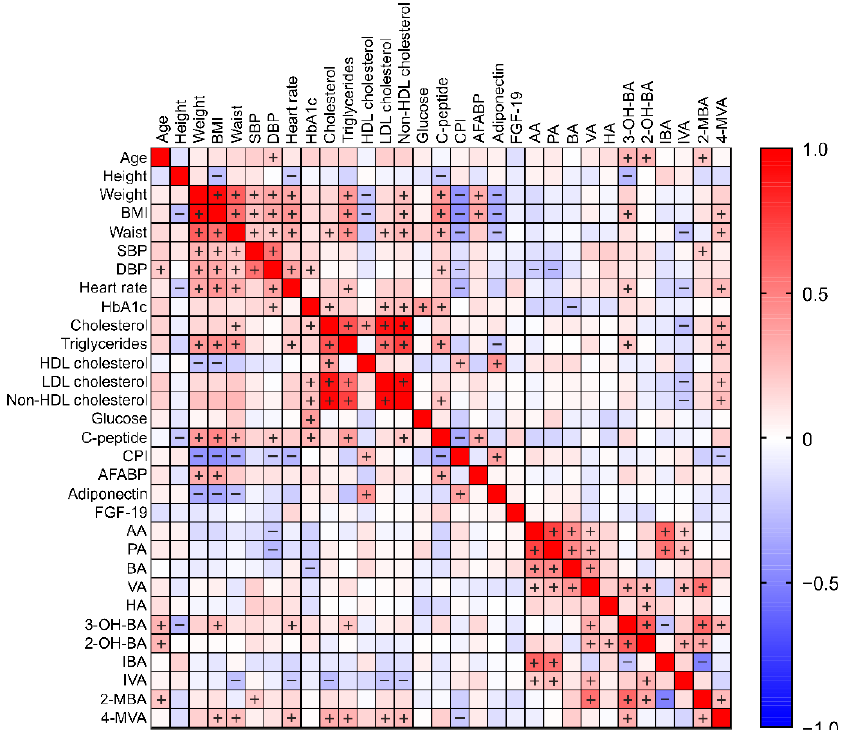
Figure 3. Pearson correlation (n = 124) of SCFA and their derivatives with baseline body composition characteristics and biochemical biomarkers for all groups. Critical value of significance is r > 0.196. Correlations above the critical value are highlighted with +/ − signs. Abbreviations: BMI, body-mass index; SBP, systolic blood pressure; DBP, diastolic blood pressure; HbA1c, glycated